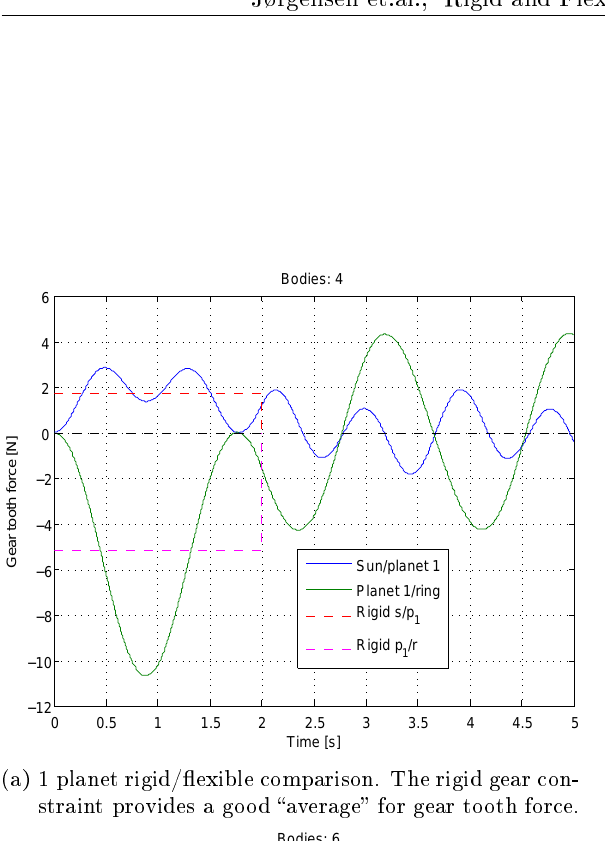
(a) 1 planet rigid/(cid:29)exible comparison. The rigid gear con- straint provides a good (cid:16)average(cid:17) for gear tooth force.